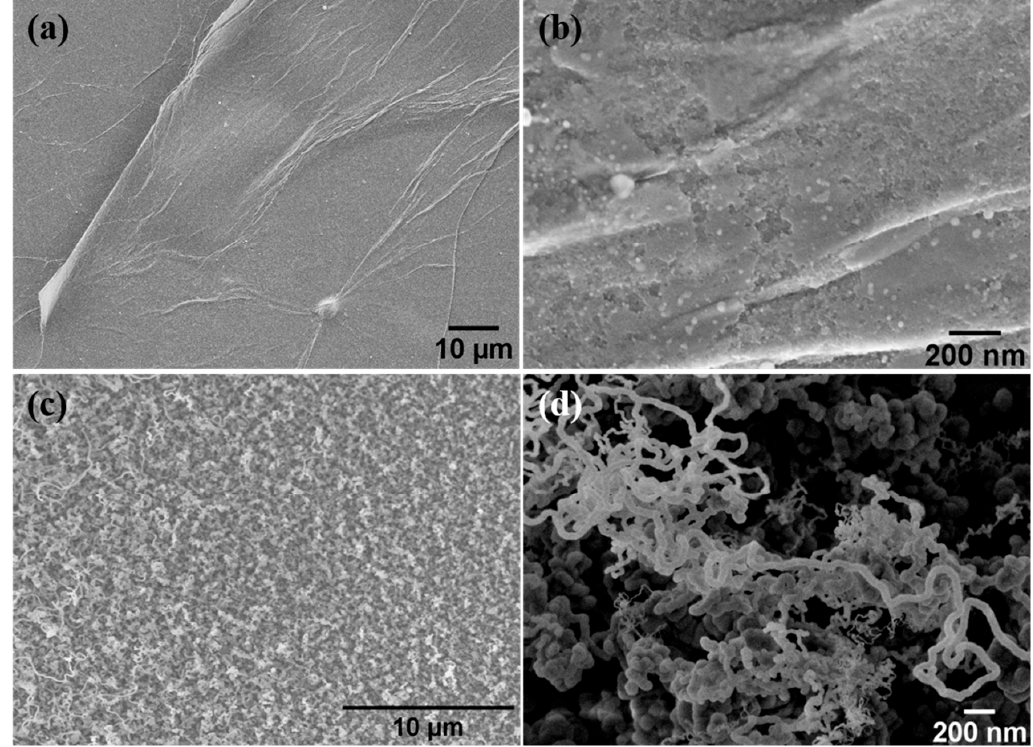
Figure 3. FE-SEM images of sample A ( a , b ) (nanoparticles decorating rGO sheets) and sample B ( c , d ) (the CSNW obtained from the thermal annealing of the GO at 1000 °C, using a Si wafer as support). The HR-TEM images of individual nanoparticles of samples A and B are shown in Figure 4b,e, respectively. It is seen that both are 30 nm diameter ball-shaped nanoparticles, apparently coated with an rGO shell. A careful determination of interplanar spacing revealed that various crystalline